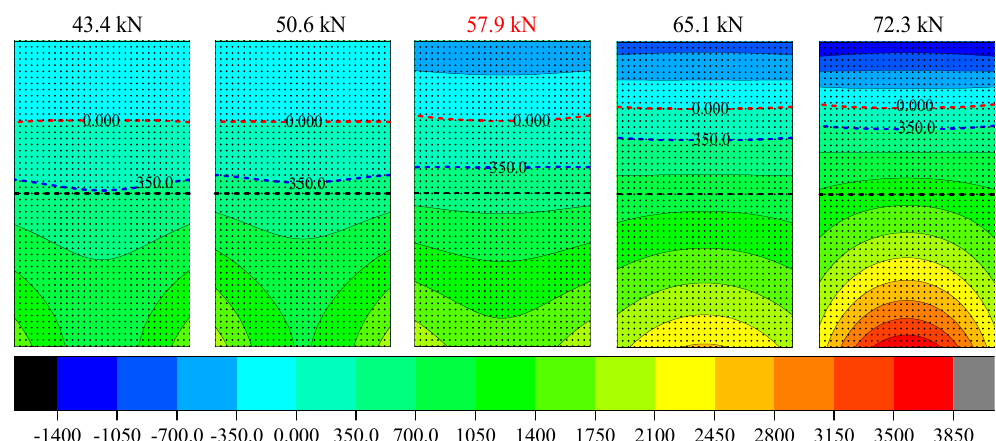
Figure 13. The strain contour maps of HG-1-12.